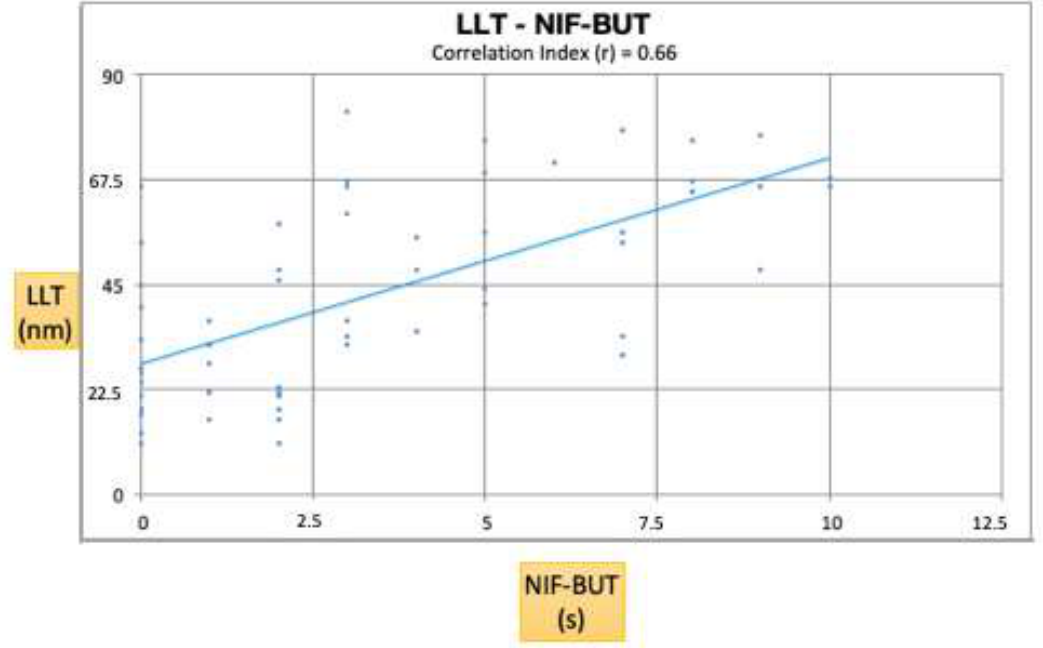
Figure 5. NIF-BUT and LLT are the two most significant parameters for the diagnosis of lipid tear dysfunction. This graph shows a positive correlation between these two parameters (r = 0.66; p < 0.001). The VAS mean value was 27 ± 9.3, while the SANDE frequency and severity mean values were 50.93 ± 14.26 and 48.1 ± 6.99, respectively. There was a positive correlation between the VAS and the skin score (r = 0.38; p < 0.05), showing marked symptoms in subjects with more a serious disease (Figure 6). On the contrary, no correlation was found between SANDE, neither the frequency nor the severity, and the skin score (frequency: r = 0.03, p > 0.05; severity: r = 0.16, p > 0.05) (Figure 6).